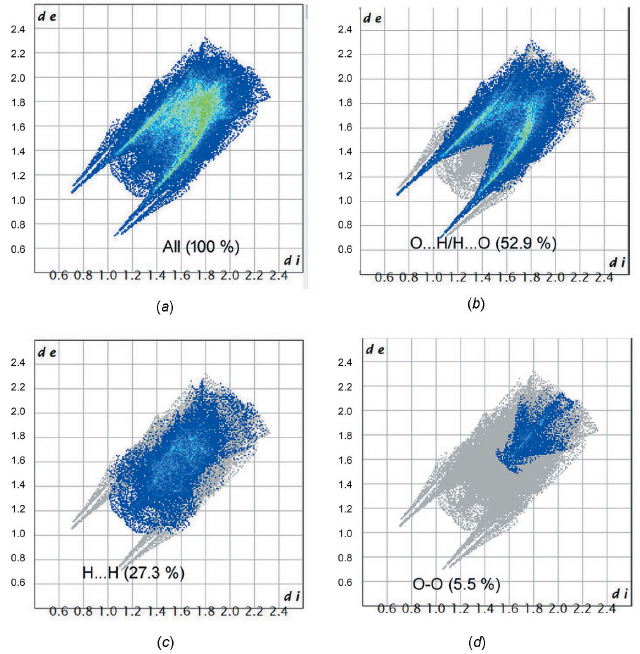
Figure 8 Two-dimensional fingerprint plots for the title compound showing ( a ) all interactions, ( b ) O (cid:2)(cid:2)(cid:2) H/H (cid:2)(cid:2)(cid:2) O interactions, ( c ) H (cid:2)(cid:2)(cid:2)(cid:2) H interactions and ( d ) O (cid:2)(cid:2)(cid:2) O